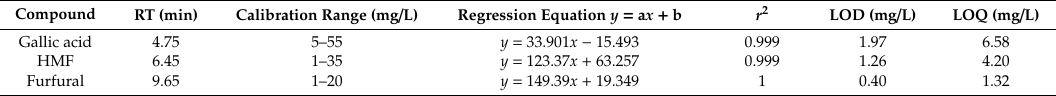
Table 1. Compound name, linear parameters and analytical limits of the high-performance liquid chromatography method coupled with photodiode array detection (HPLC-PDA) method for the quantification of the main compounds identified in carob